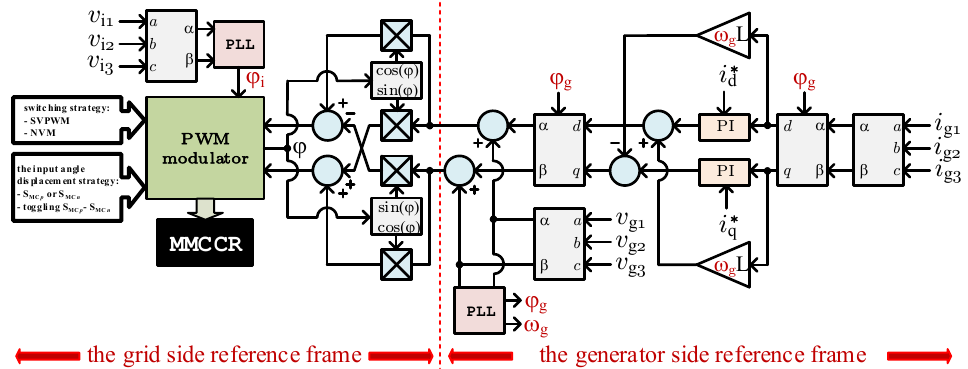
Figure 22. The proposed control scheme: PLL—phase-locked loop, MMCCR—the proposed con- verter, PI—standard proportional integral controller, ϕ i —grid’s voltage angle, ϕ —the synchroni- sations angle, ϕ g —generator’s voltage angle, i ∗ —an active reference current for generator, i q —a d reactive reference current for generator, ω g = ω m —for simplicity, mechanical pulsation is equal to